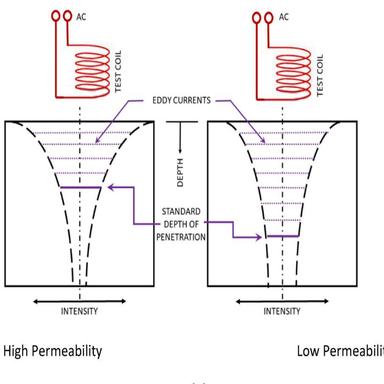
(A) Relative magnitude and distribution of eddy currents in good or poor conductors, (B) relative magnitude and distribution of eddy currents in conductive material of high or low permeability.